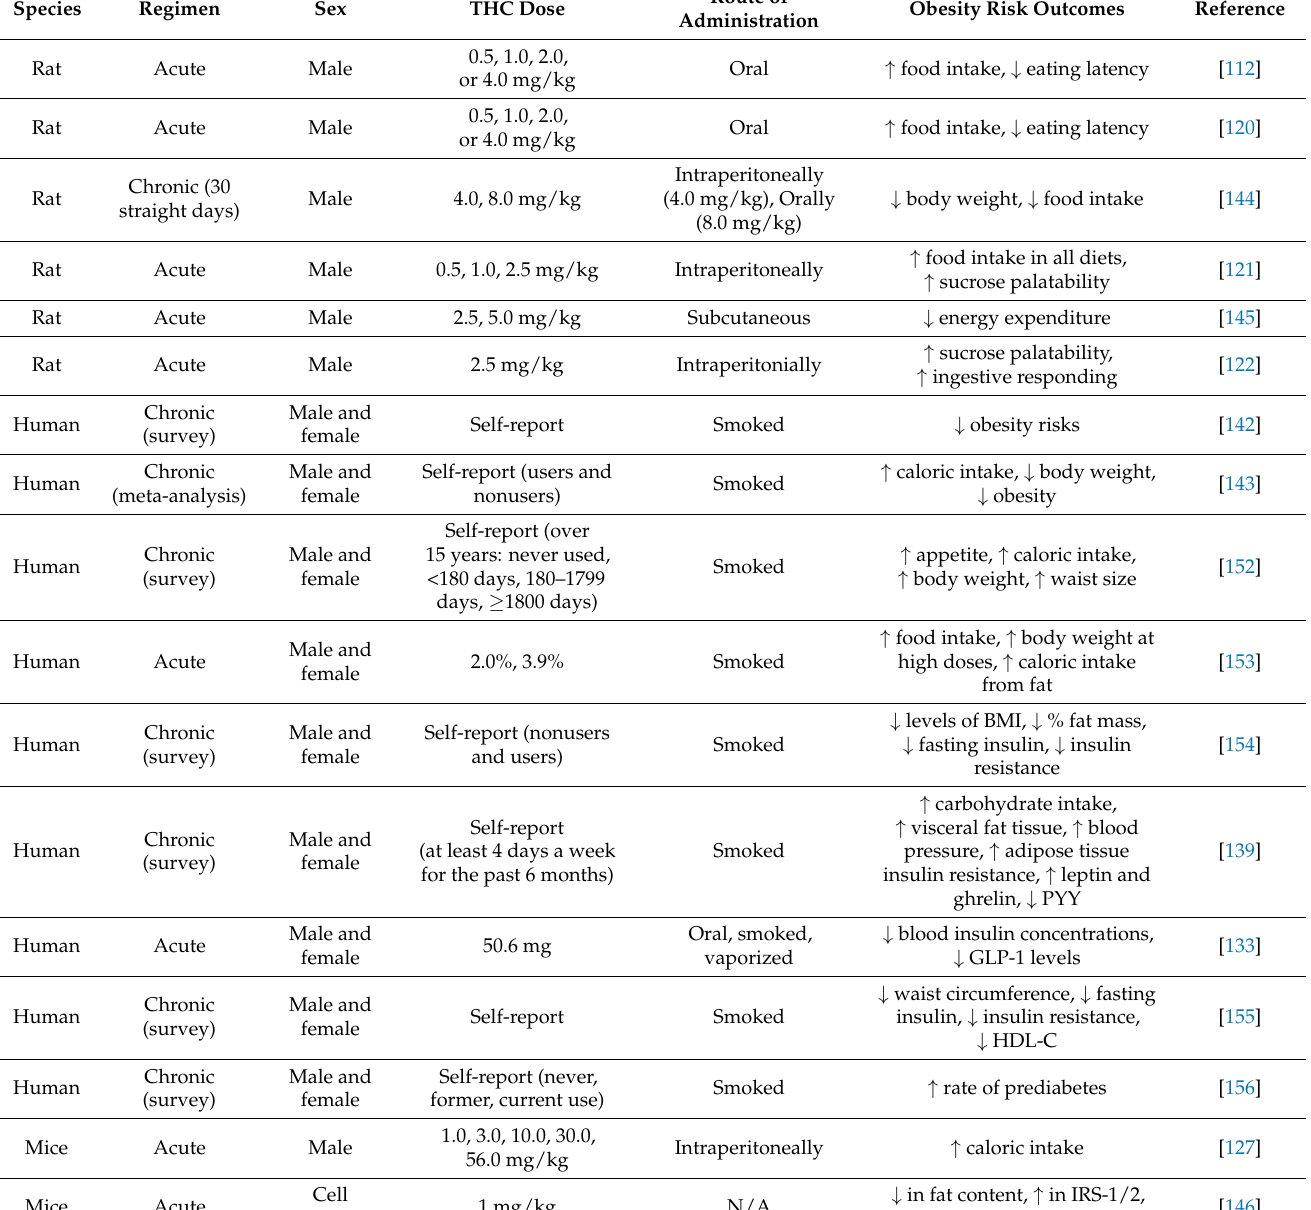
Table 1. A summary of preclinical and clinical studies in adults treated with THC and outcomes on obesity-related symptoms. Most symptoms included were based on food/caloric intake, body weight, and BMI, but some other obesity-related features included energy expenditure, insulin resistance, and visceral fat content. The limited information in certain sources resulted in some of the information that would have been contained within the table being